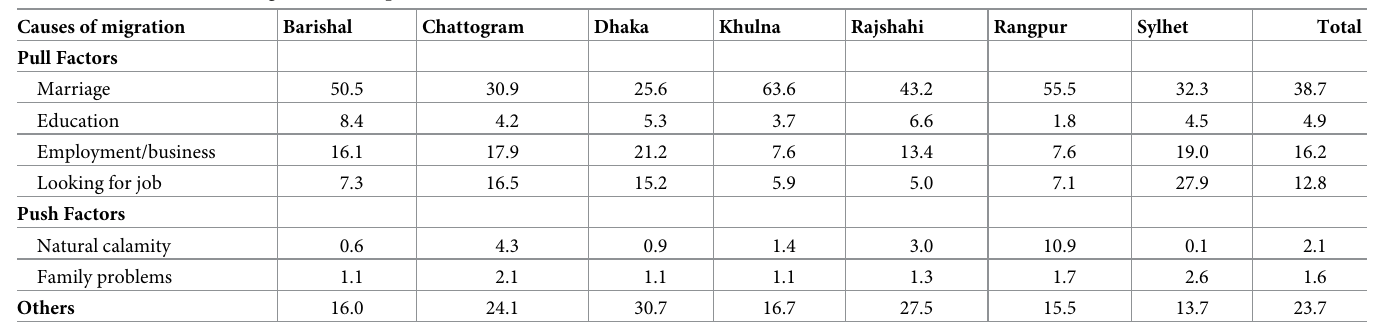
Table 5. Causes of internal migration: Push-pull factors,